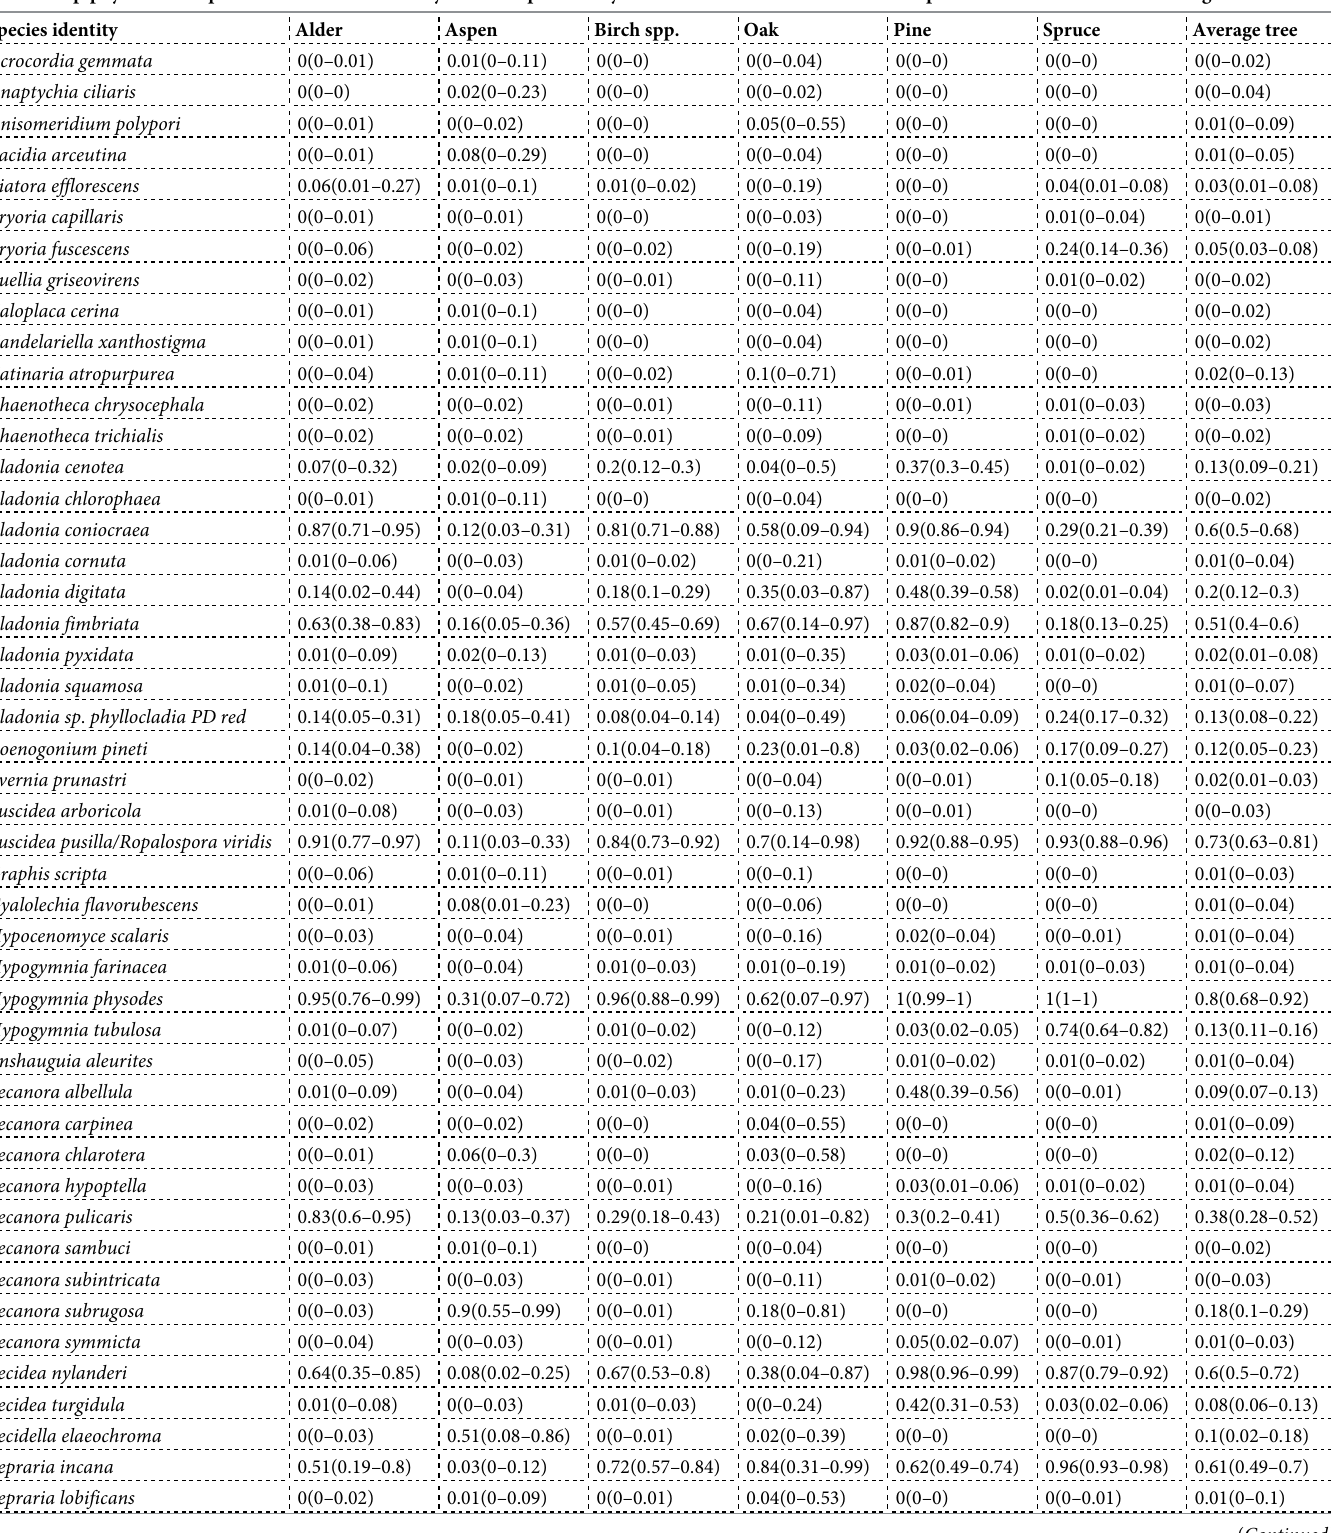
Table 1. Epiphytic lichen species observed in this study and their probability of occurrence on a certain host tree species as well as on a tree in